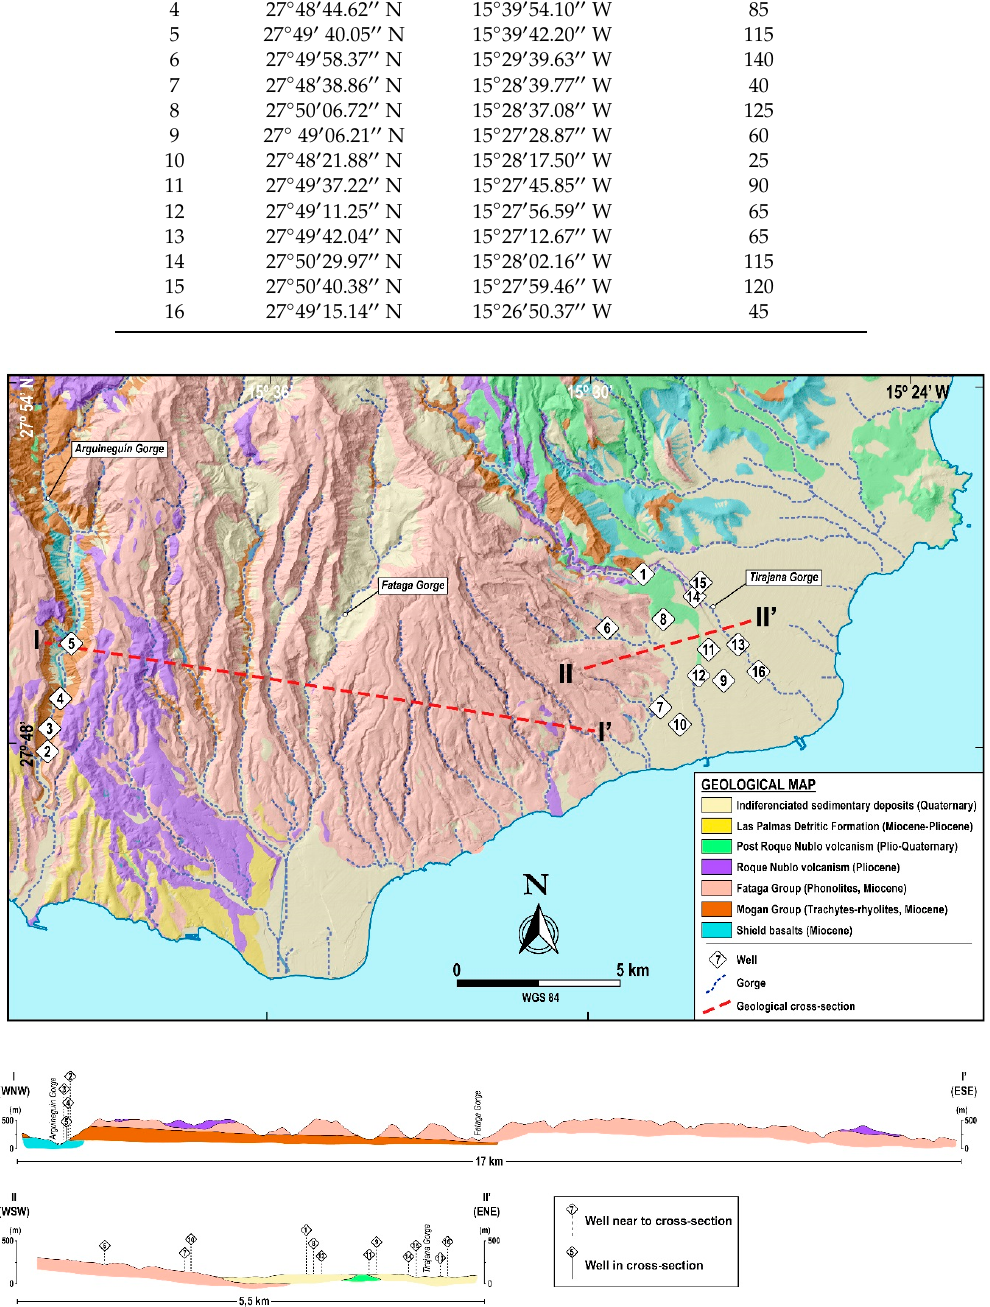
Figure 3. Orography of the terrain in the area under study, and location of the 16 wells with